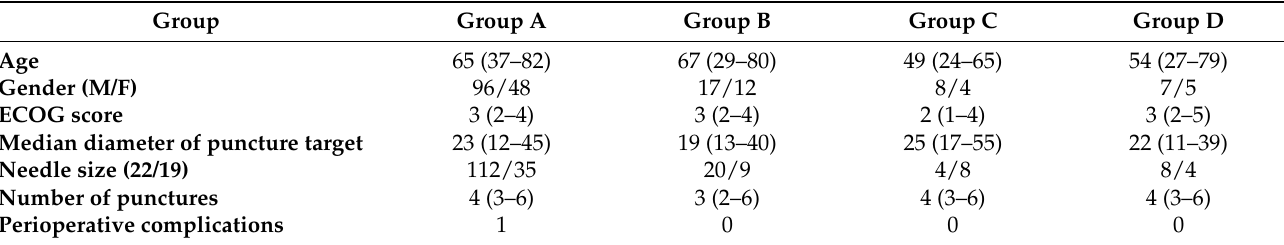
Table 1. Patients and procedure